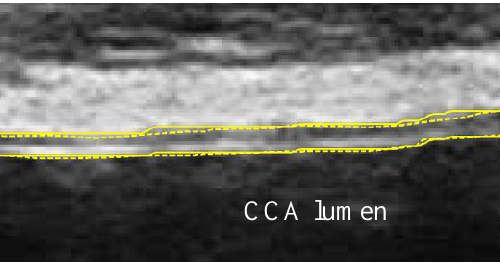
Figure 11. Result superimposed on the raw sub-image. Solid line: automatic detection result. Dash line: Manual drawing. (Sequence S3).